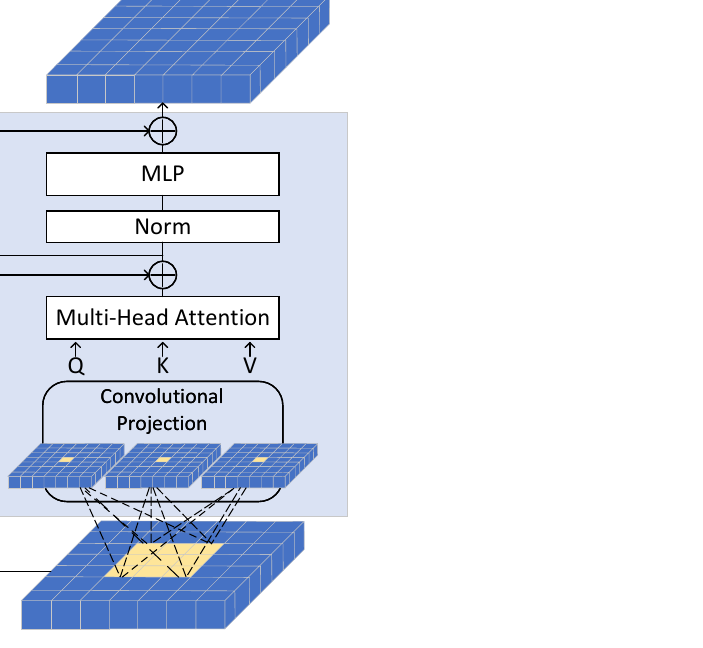
Figure 7. Convolutional transformer